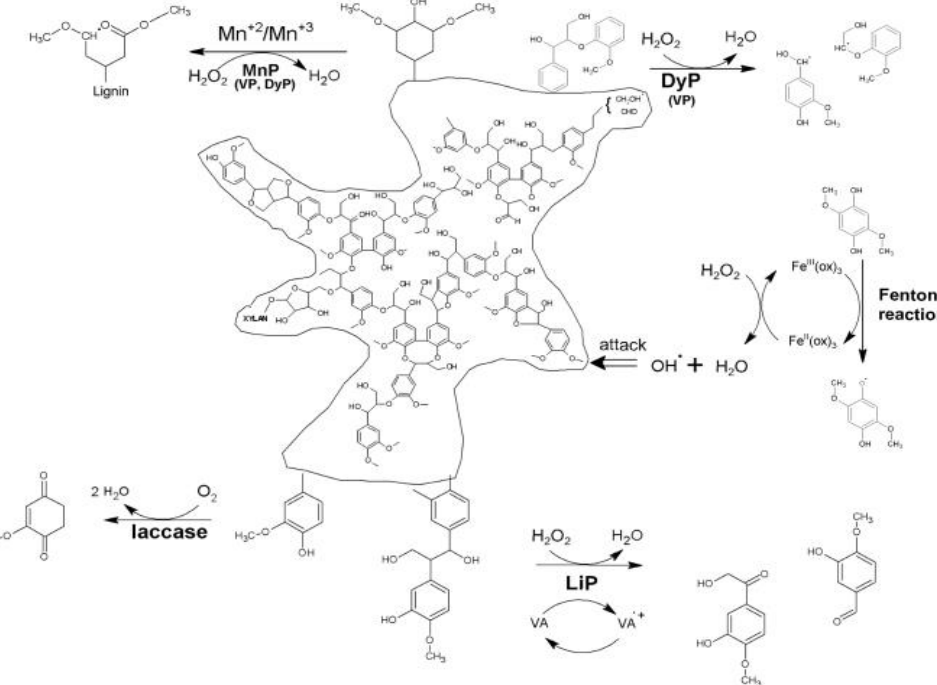
Figure 2. Schematic description of catalytic cycle of Thermomonospora curvata DyPs. Fernandez-Fueyo and colleagues [153] have shown that DyPs enzymes, Pleos -DyP1 and Pleos -DyP4, from fungi Pleurotus ostreatus have the ability to oxidize Mn 2+ to Mn 3+ , a feature mostly present in MnPs and versatile peroxidases (VPs).